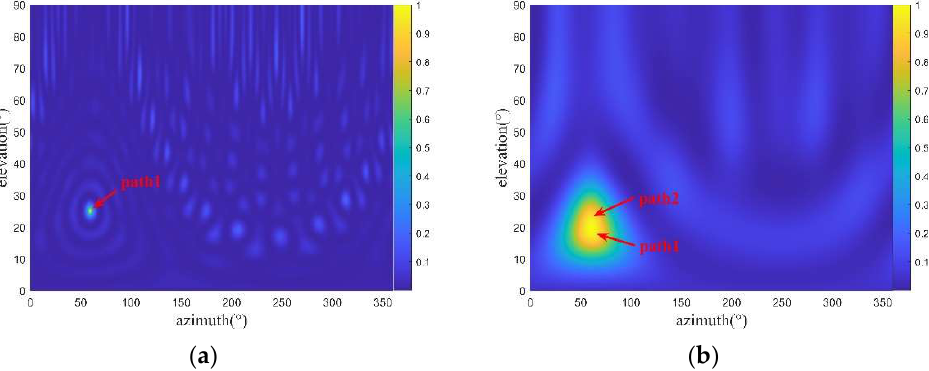
Figure 3. Spatial spectrogram examples of a single path ( a ) and two paths ( b ) (top view).